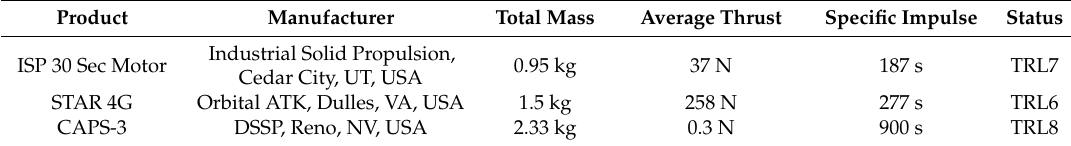
Table 9. Solid Rocket Motor Performance [23].